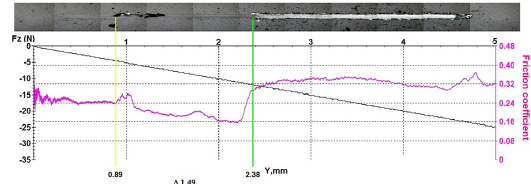
Figure 6. Friction coefficient (pink) and applied load (black) as a function of track distance obtained for scratching test for sample 4. Table 4. Critical loads of the sample.